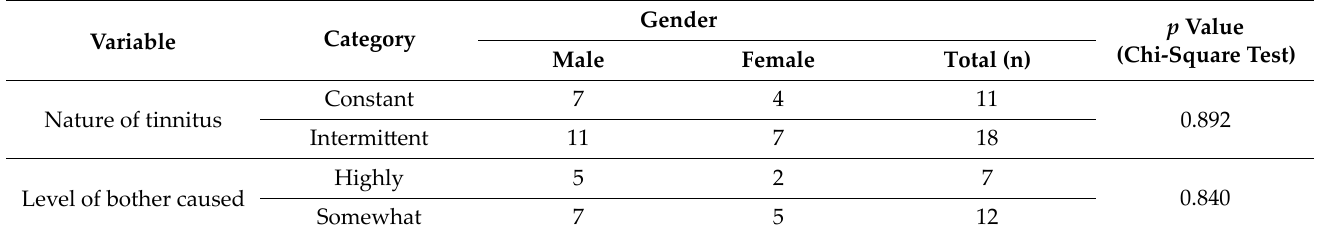
Table 4. Nature of tinnitus and level of bother it caused in relation to gender.